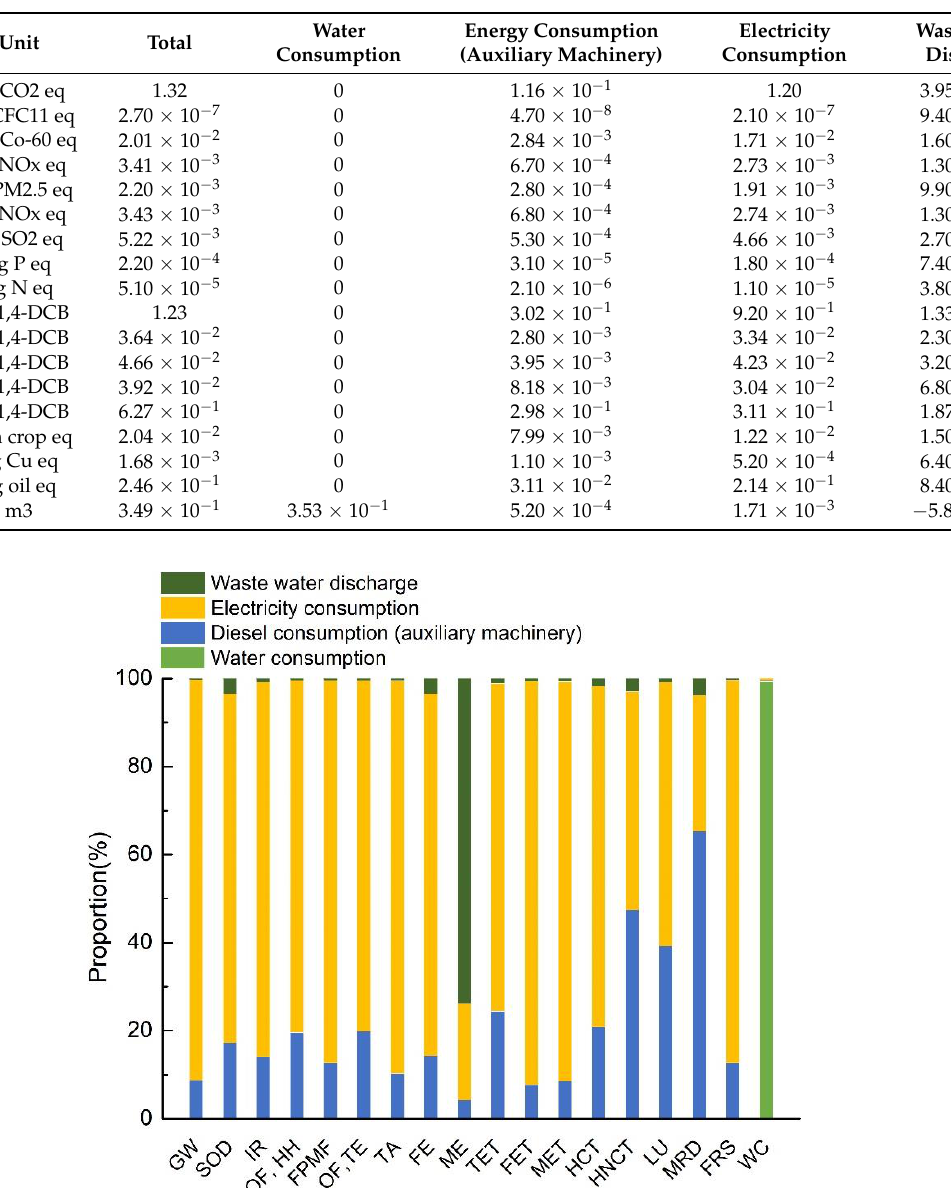
Table 4. Normalized LCA results for Scenario 1.